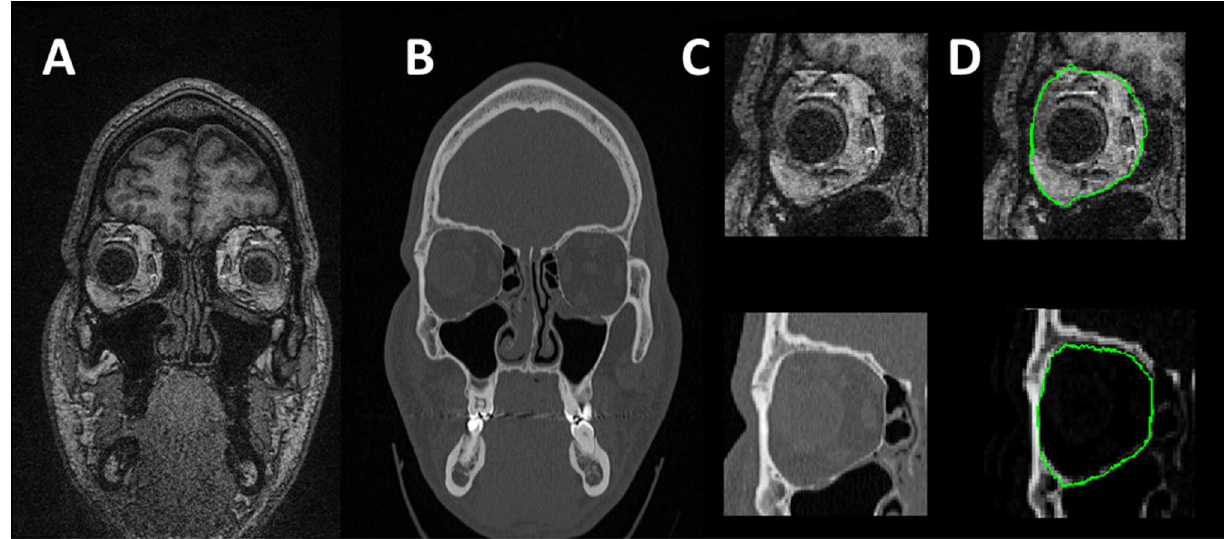
Figure 1. An example of a coronal plane image from the dataset for both T1-weighted 3 T MRI ( A ) and CT ( B ). Images belong to the same subject and represent approximately the same cross-section. A subplot of the region of interest (right orbit) for both imaging modalities is shown without ( C upper panel MRI, lower panel CT) and with ( D upper panel MRI, lower panel CT) the boundaries of the intraorbital bony contours in